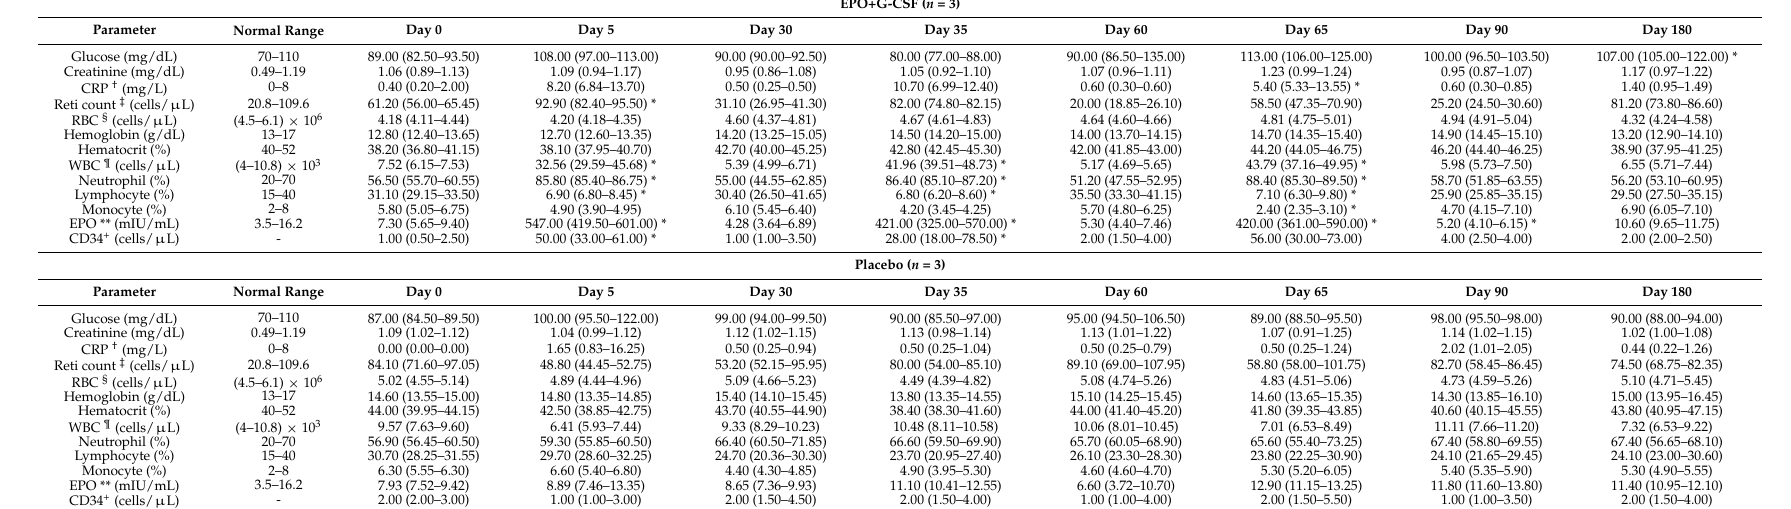
Table 3. Hematological parameters of the EPO and G-CSF combination therapy in stroke patients in an exploratory double-blind